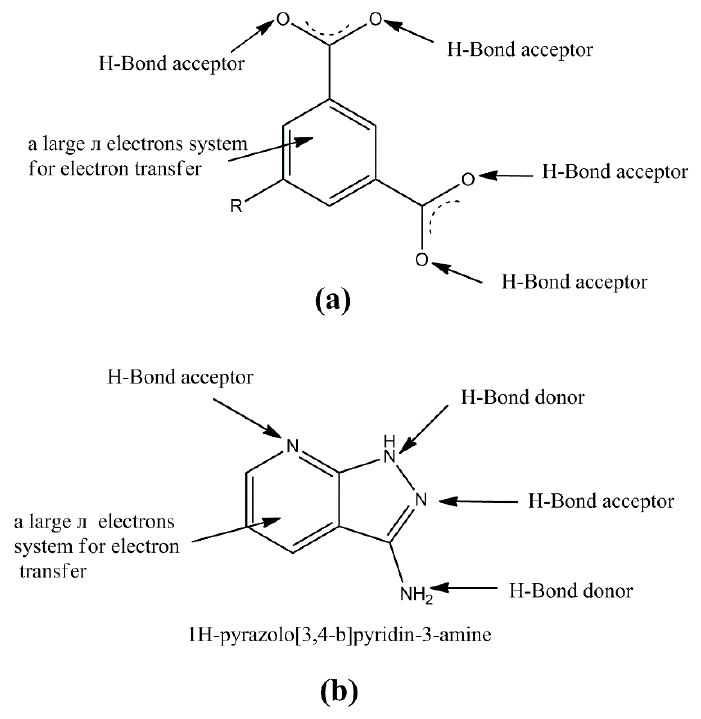
Figure 1. ( a ) Possible noncovalent interactions in ligands of 1,3-benzenedicarboxylate derivatives and ( b ) possible noncovalent interactions in the ligand of